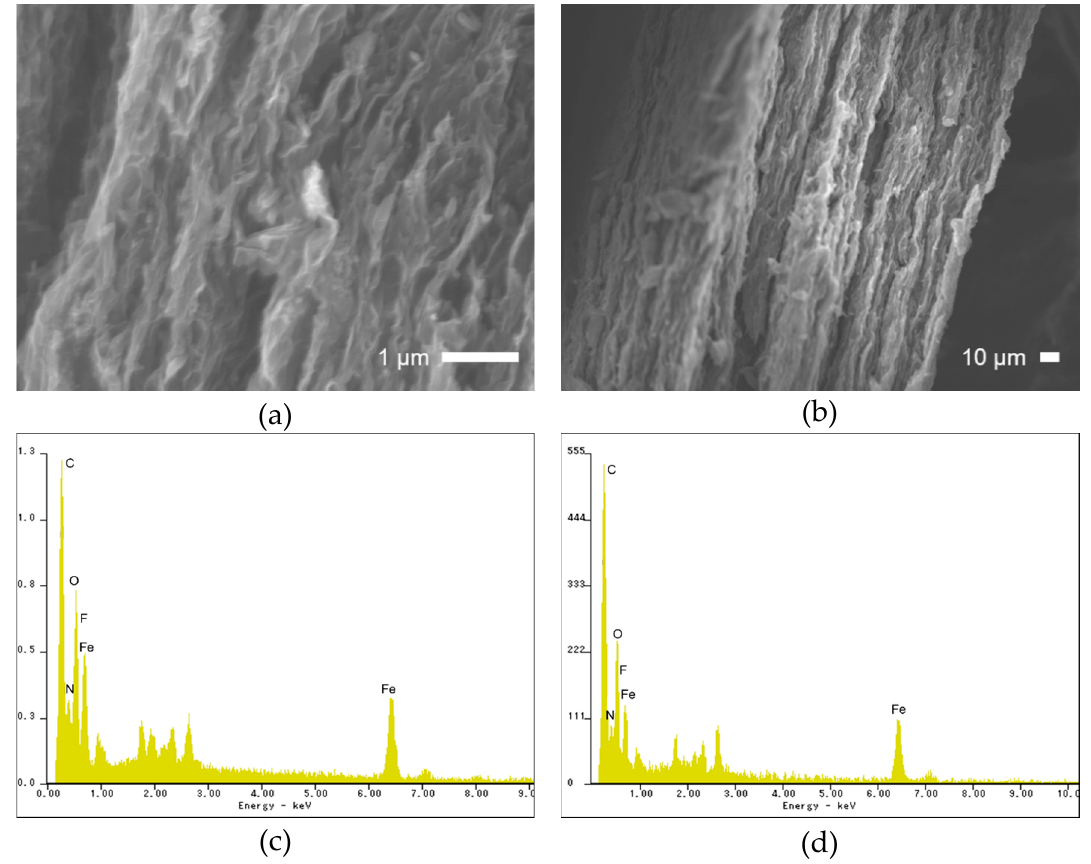
Figure 2. Scanning electron microscopy (SEM) images of ( a ) composite 1 and ( b ) composite 2 .